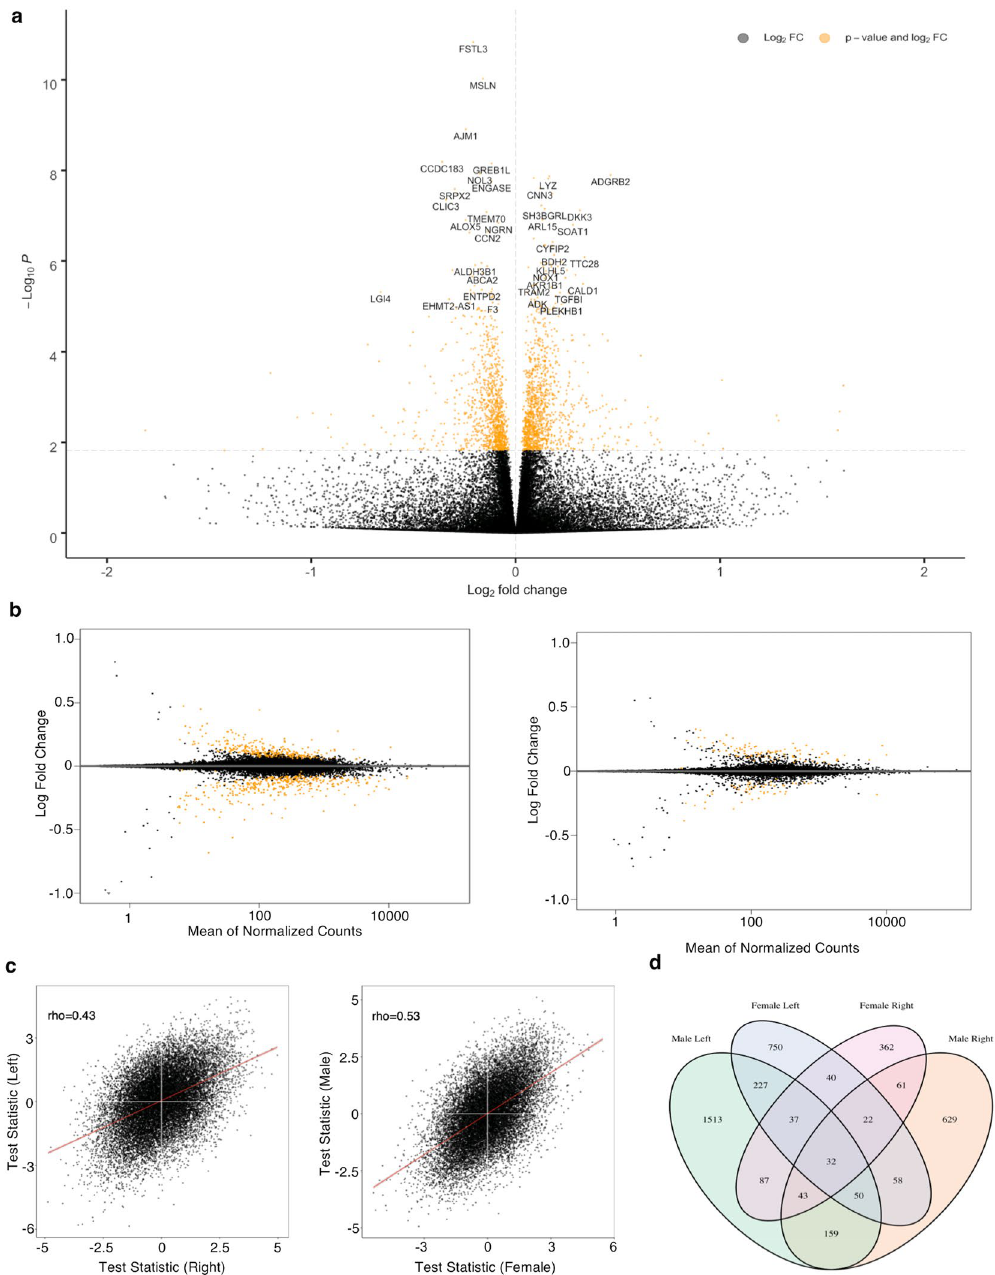
Figure 1. Summary of regression analysis for RNA-seq. ( A ) Volcano plot of DEGs. Positive log fold change corresponds to increased expression in ethanol-treated organoids. ( B ) MA plot highlighting differential expression in left colon (left panel) and right colon organoids (right panel) in response to ethanol. Orange values indicate significance. Positive log fold change corresponds to increased expression in vehicle control organoids. ( C ) Test-statistics generated from each colon location (left panel) and sex (right panel) subsets were correlated (spearman rank) to each other. ( D ) Stratified analysis by colon location and sex revealed that a greater number of nominal DEGs were identified in male, left colon organoids than any other